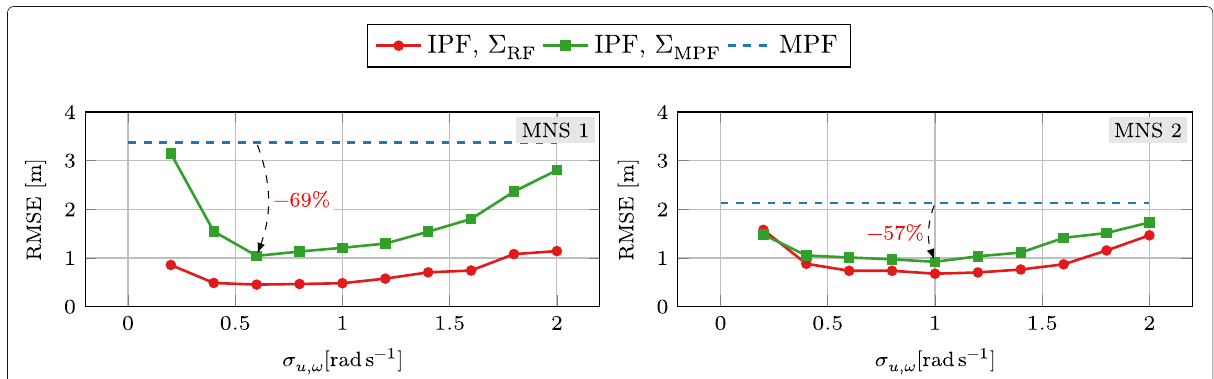
Fig. 6 Comparison between the MPF and IPF algorithms for L = 100 and varying input variances. The left panel shows the results for MNS 1, and the right panel shows the results for MNS 2